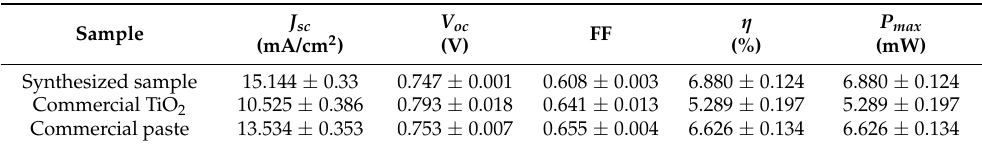
Table 2. Photovoltaic properties of fabricated DSSC integrated with the synthesized sample, the commercial TiO 2 , and the commercial paste as the photoelectrode